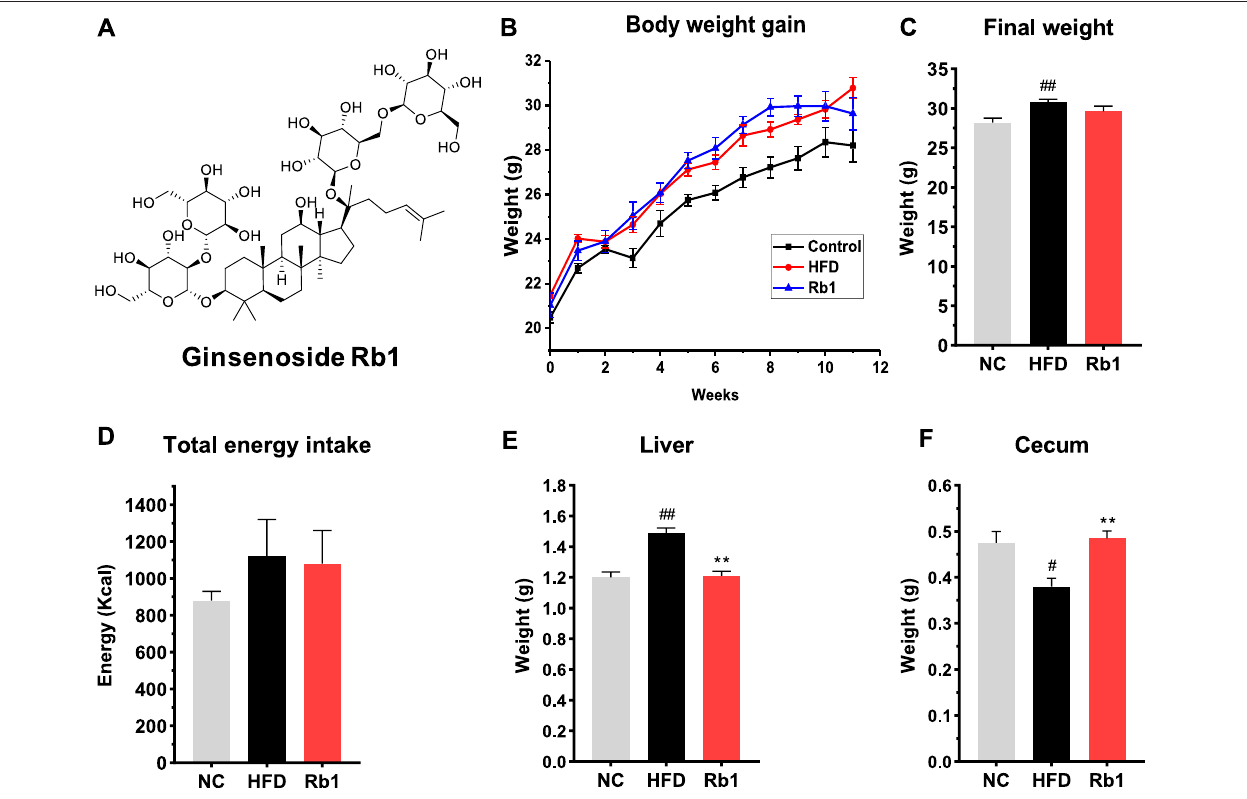
FIGURE 1 | The effects of Rb1 supplementation on body composition. (A) structure of ginsenoside Rb1; (B) Weight gain assessed weekly; (C) Final body weight; (D) Total energy intake; (E) Liverweight; (F) Cecum weight. The dataare expressed as themean ± SEM; n (cid:1) 6; one-way analysisofvariance with Tukey ’ spost-hoc test. # p < 0.05, ## p < 0.01, for NC vs HFD; * p < 0.05, ** p < 0.01 for Rb1 vs